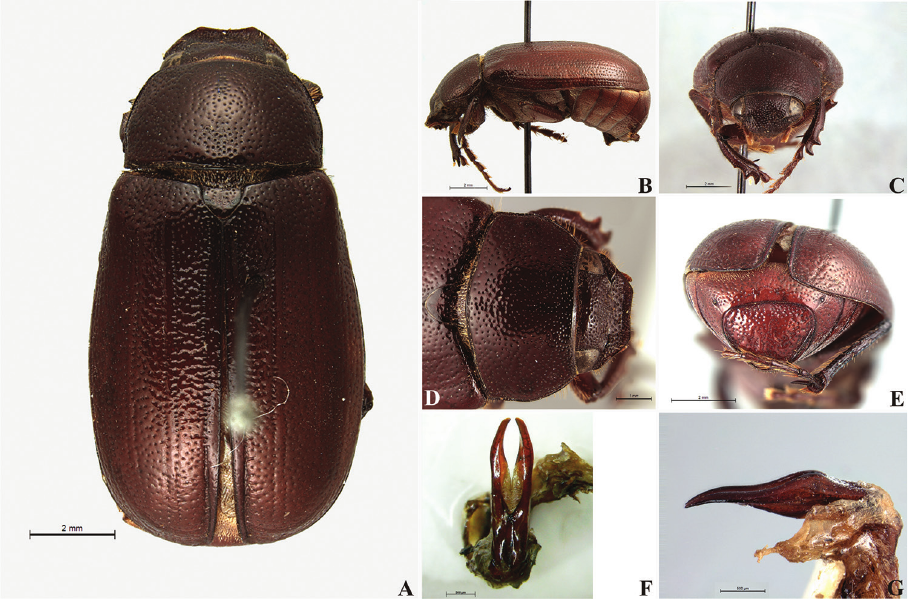
Figure 63. Liogenys elegans Nonfried. A Dorsal view B Lateral view C Frontal view D Clypeus and pronotum E Pygidium F Parameres, dorsal view G Parameres, lateral